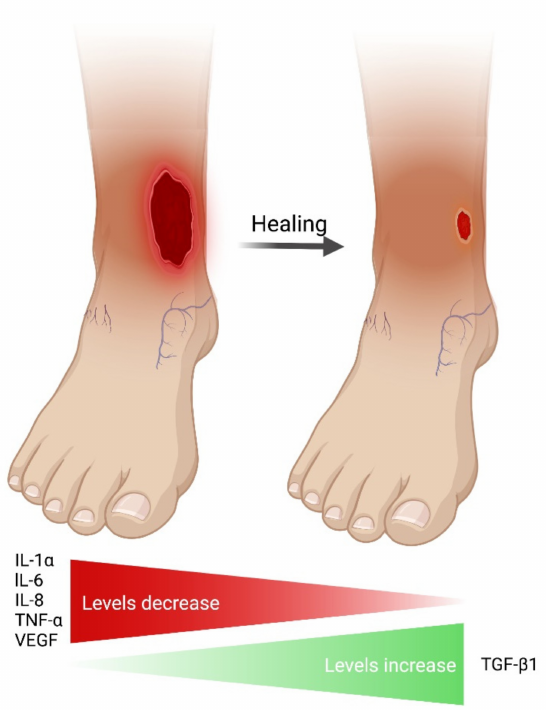
Figure 3. Elevated cytokines ( p < 0.10) shown in at least three studies in this